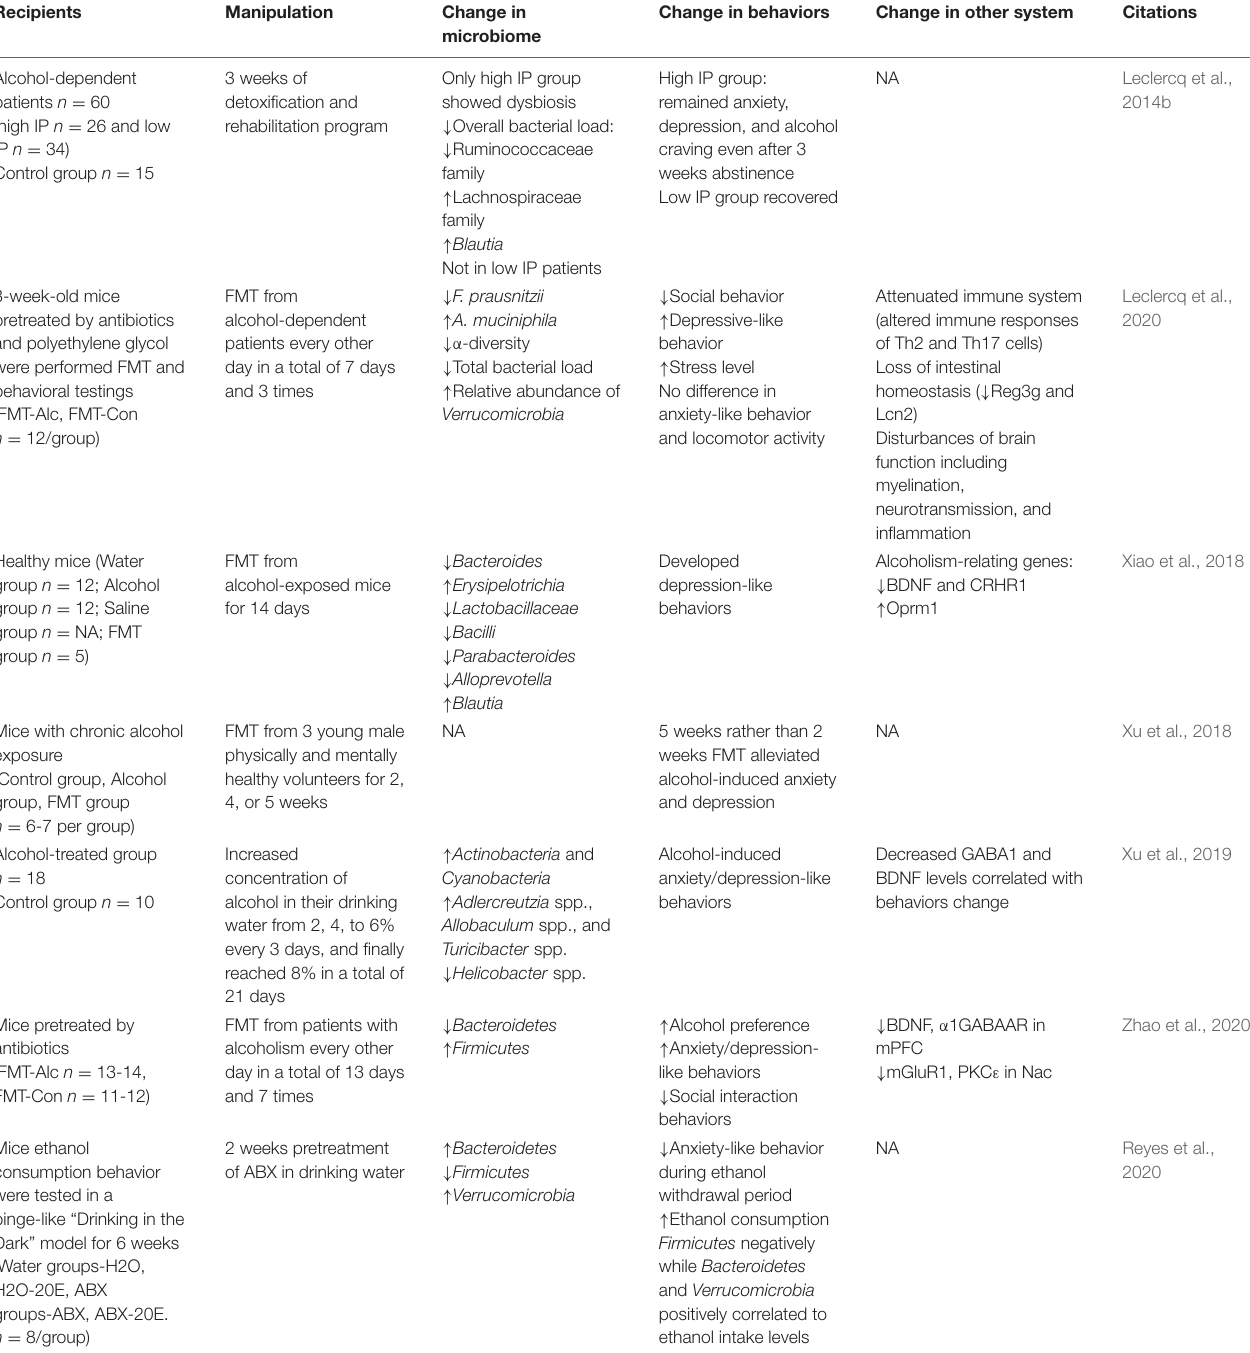
TABLE 3 | Interventions altering the gut microbiome in alcohol-related depression and